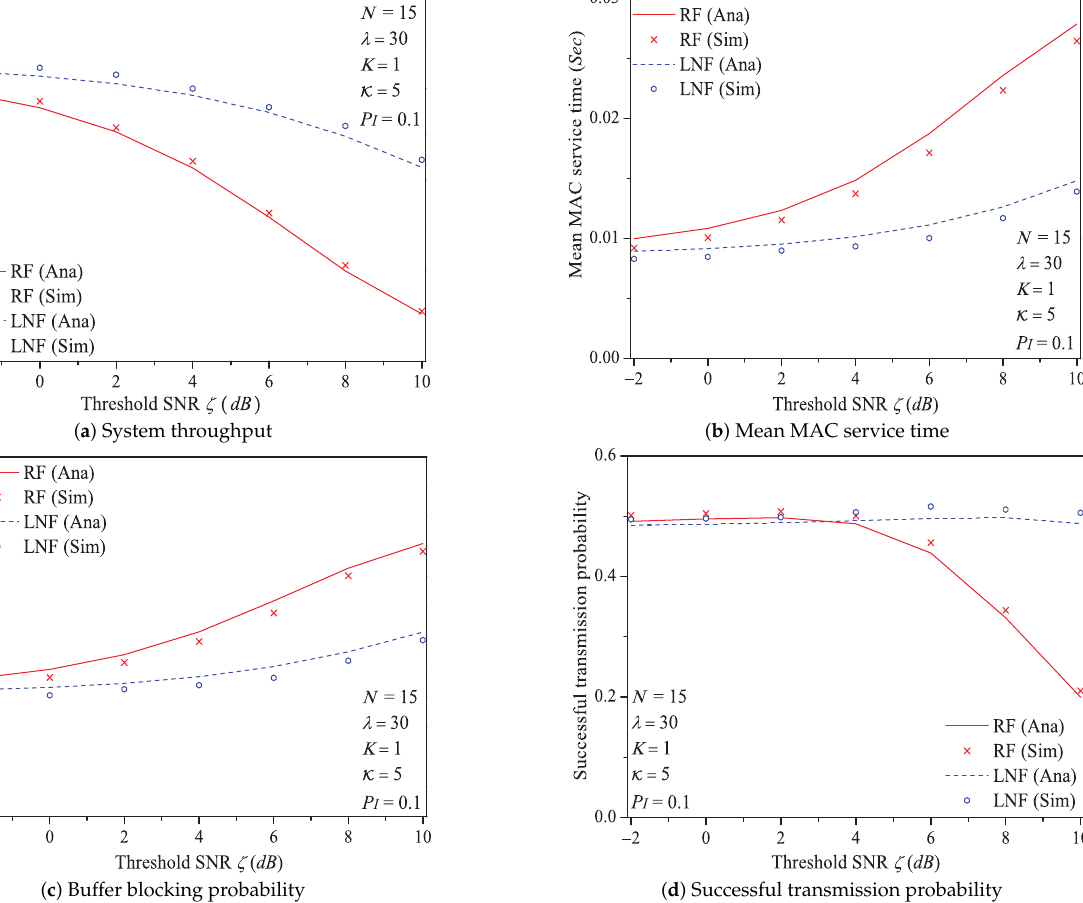
Figure 7. The MAC performance of 1901 protocol with different ζ